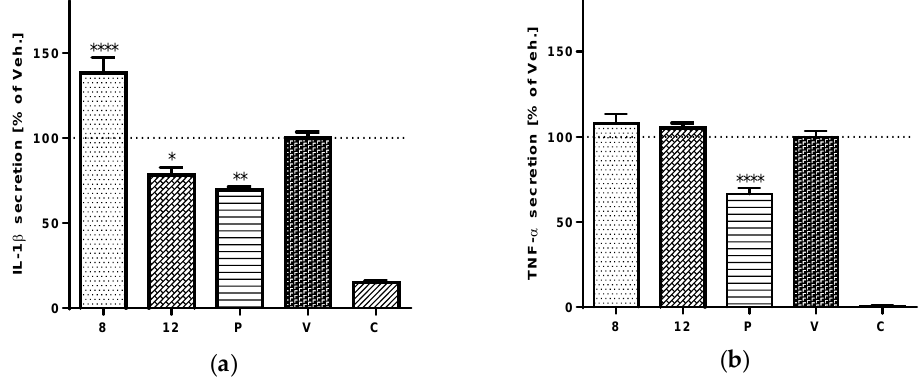
Figure 4. The effects of compounds 8 and 12 on the secretion of pro-inflammatory cytokines IL-1 β ( a ) and TNF- α ( b ). PMA-differentiated macrophages were pre-treated with test compounds 8 and 12 at a concentration of 5 μM, with prednisone (P) 1 μM dissolved in DMSO, or with only the vehicle (V). LPS 1 μg/mL was added (to all but C, control cells) after 1 h of incubation. After 24 h, the supernatants were collected and the secretions of IL-1 β and TNF- α in each culture medium were evaluated using ELISA. Results are expressed as the mean ± SE for three independent experiments. * indicates a significant difference ( p < 0.05) in comparison with the vehicle-treated cells, ** indicates a significant difference ( p < 0.01) , and **** p < 0.0001.